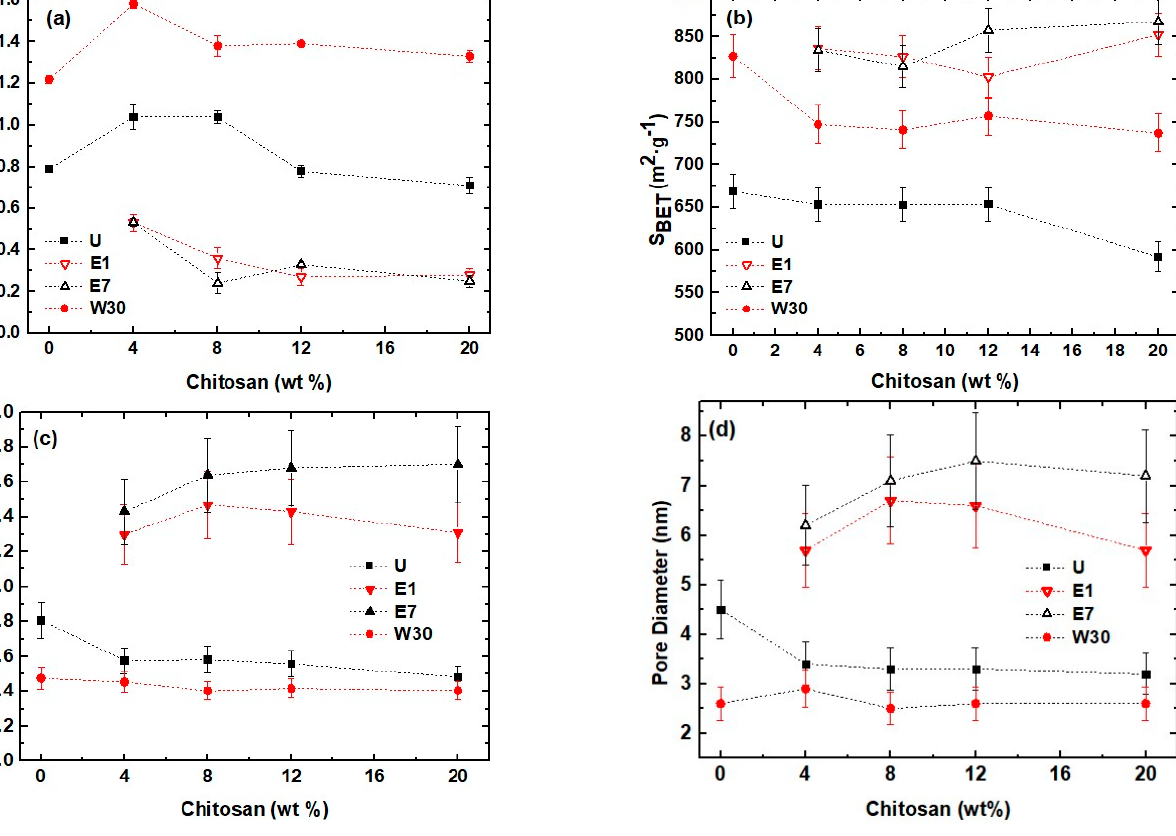
Figure 1. ( a ) Bulk density; ( b ) BET surface specific area (S BET ); ( c ) pore volume (V p ), and ( d ) pore diameter, for SiO 2 /CS xerogels as a function of the CS content.